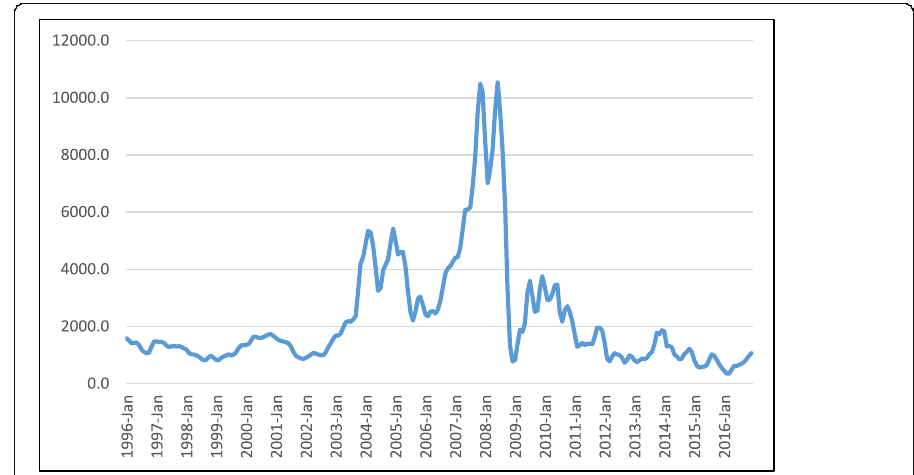
Fig. 1 The Baltic Exchange Dry Index* Moving Average. * The BDI accounts only the ships carrying DRY CARGO (oil, gas, chemicals or containers are not included) . Source: the authors based on Clarkson (2017)